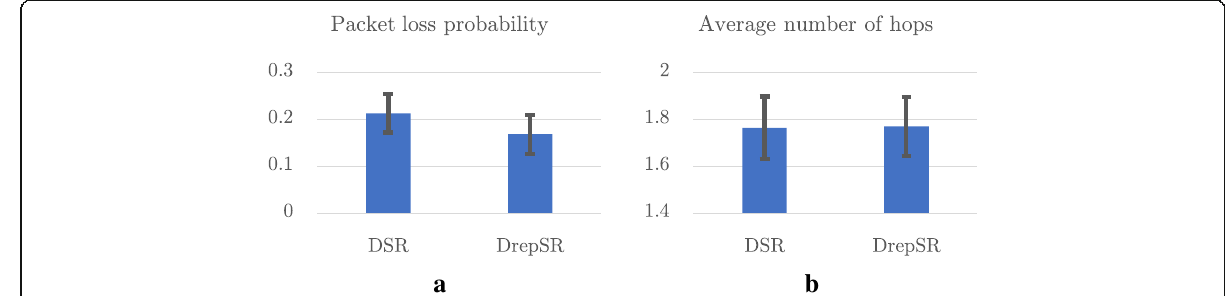
Fig. 11 Comparison of the simulated results for the DSR protocol and the proposed DrepSR routing protocol. a Packet loss probability; b Average number of hops. Figures show a 95% confidence interval using 10 independent realizations per